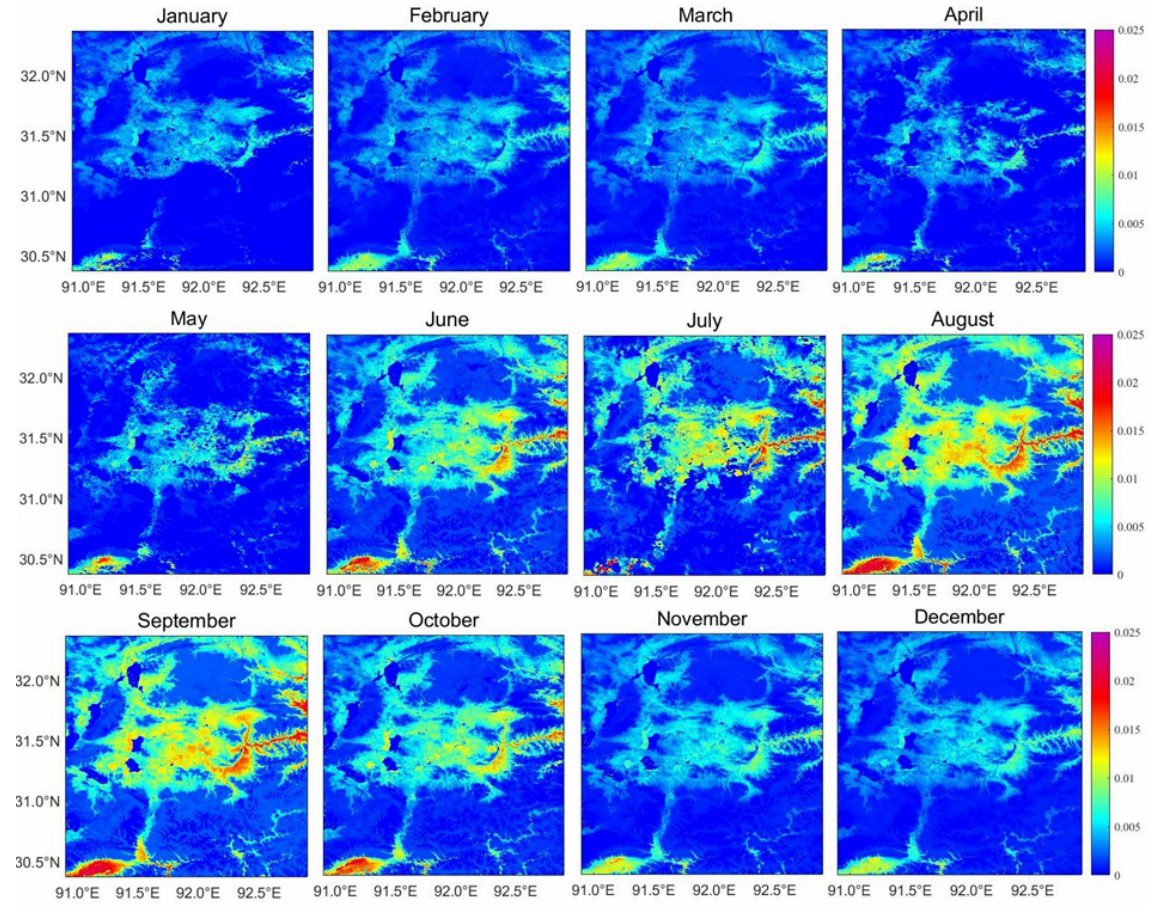
Figure 5. Surface roughness length on the northern Tibetan Plateau in 2012.